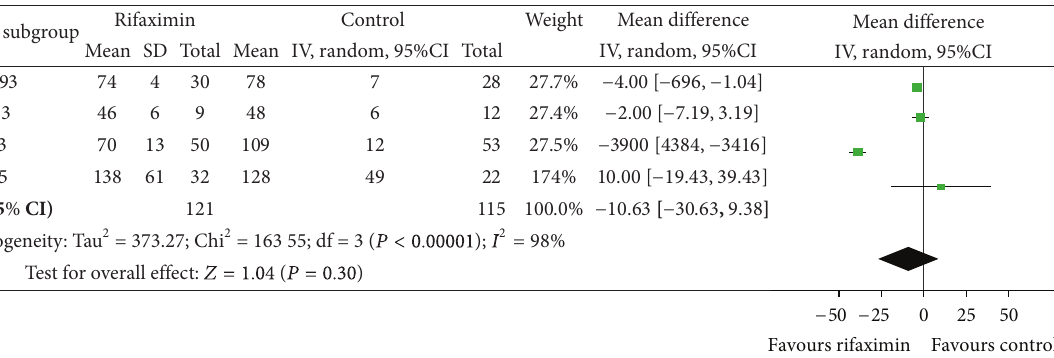
Figure 4: Blood ammonia levels at the end of treatment: rifaximin versus nonabsorbable disaccharides. IV: inverse variance.